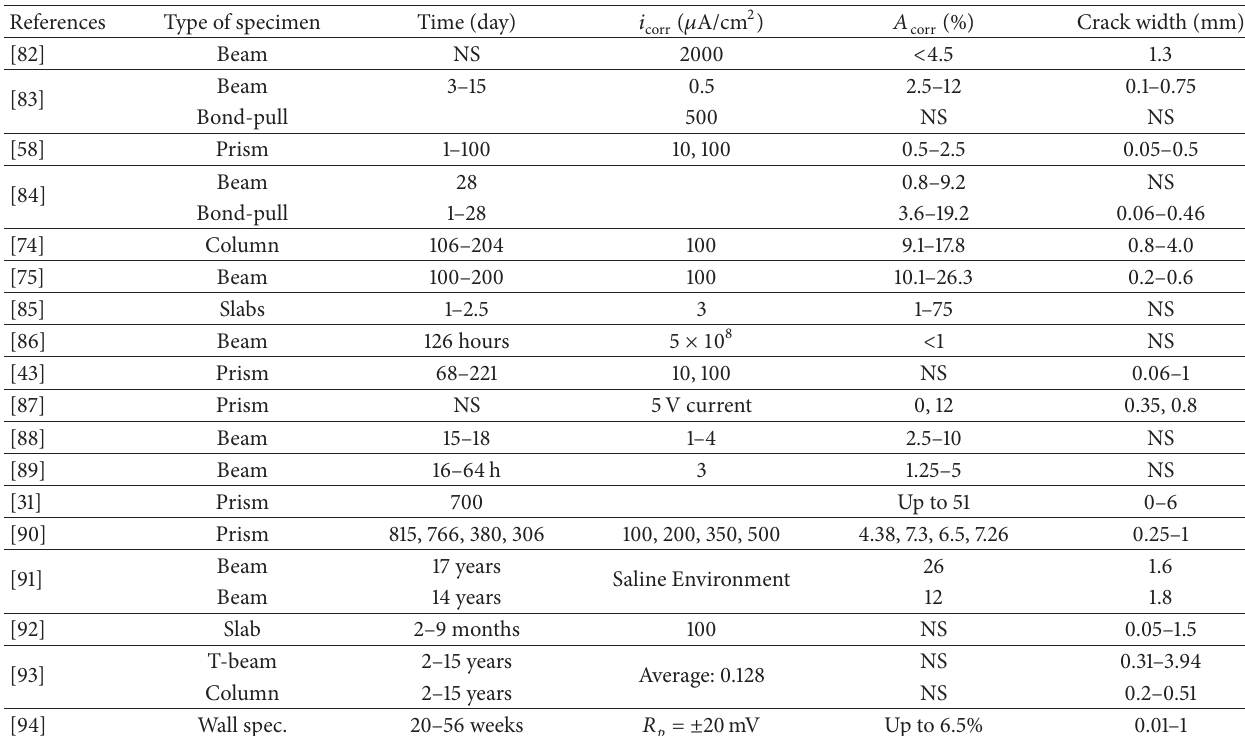
Table 7: Relationship between crack widths with corrosion obtained from